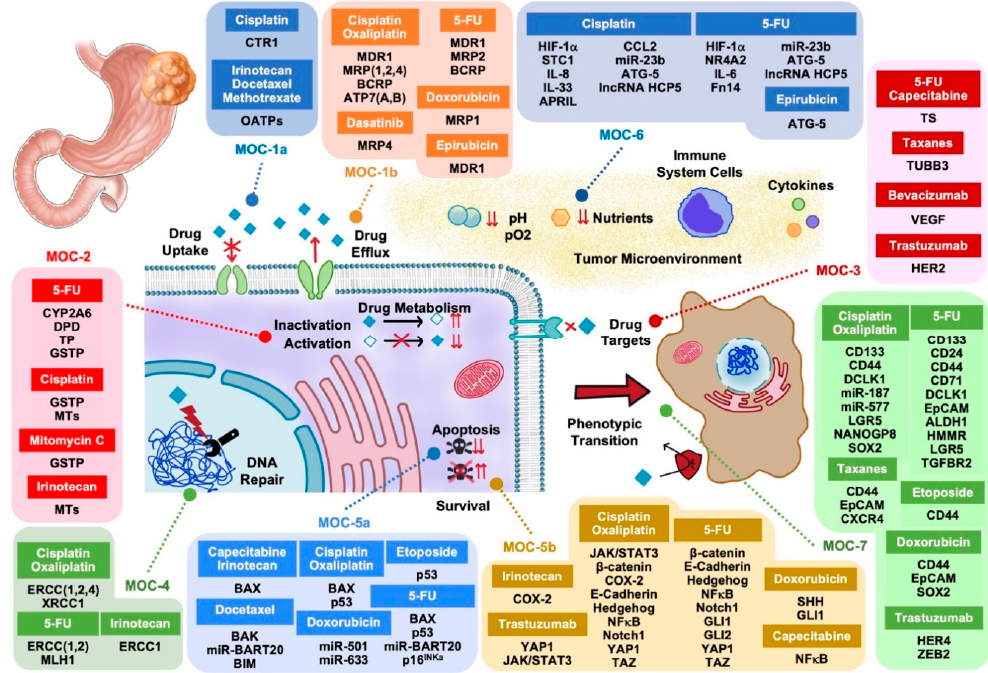
Figure 1. Proteins and non-coding RNAs accounting for drug resistance in gastric adenocarcinoma. MOC, mechanism of chemoresistance.